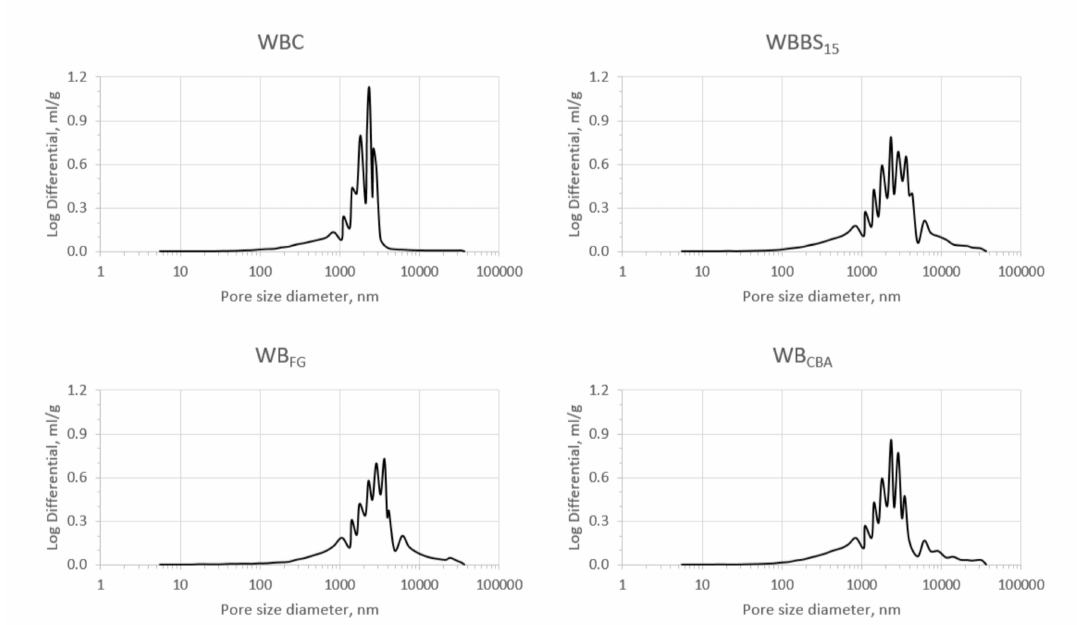
Figure 4. Pore size distributions from mercury intrusion analysis for WBC, WBBS 15 , WB FG , and WB CBA aggregates.